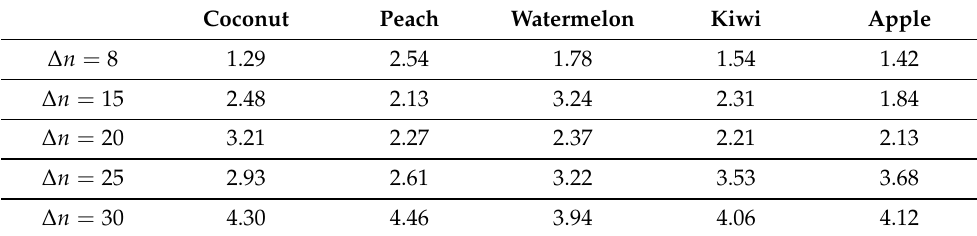
Table 3. Standard deviation of estimated rotations as a function of ∆ n and fruit type, data corre- sponding to curves of Figure 23. Coconut Peach